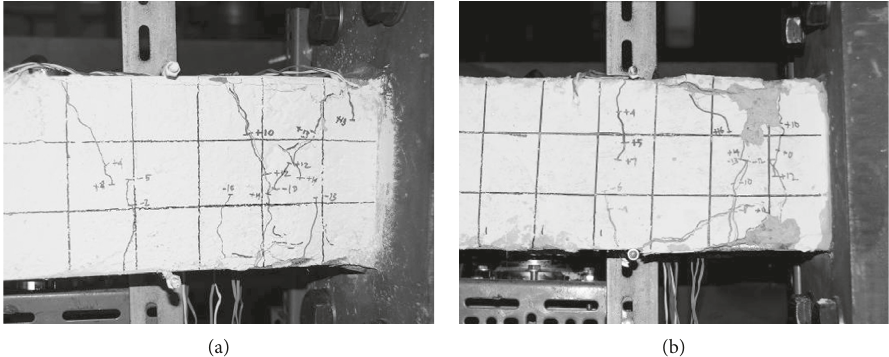
Figure 20: Crack pattern of PS-NB and PW-NB at 2nd 2.5% drift angle cycle. (a) PS-NB. (b) PW-NB.